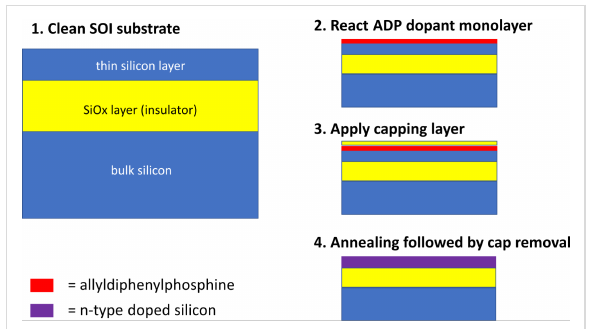
Figure 1: Schematic depicting MLD processing applied to silicon on insulator wafers. It shows monolayer formation (allyldiphenylphos- phine dopant molecules) followed by capping and finally thermal annealing and cap removal to provide an n-type doped silicon